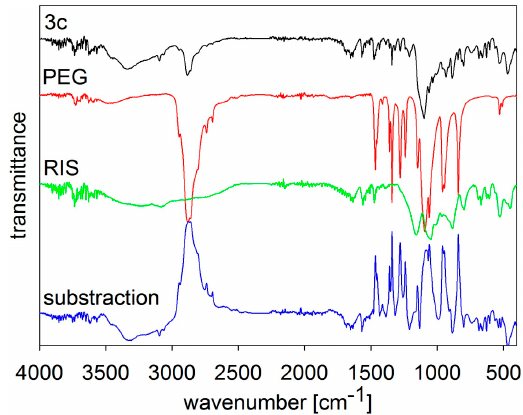
Figure 4. MIR spectra of risedronate (RIS), macrogol 6000 (PEG) and risedronate nanoparticles stabilized with 5% concentration of macrogol 6000 (Sample 3c ) and differential spectrum.